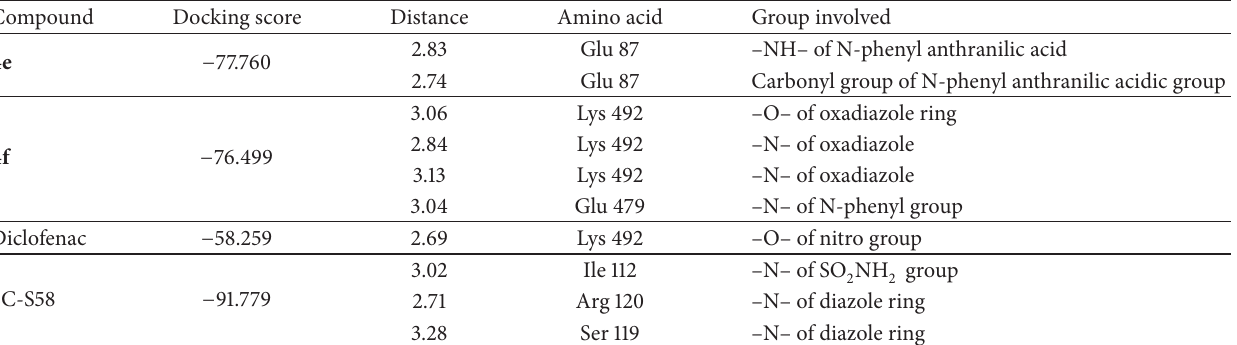
Figure5:Bindingmodesofdiclofenac,SC-S58(diclofenac,SC-S58asdockingviewanddiclofenac 󸀠 ,SC-S58 󸀠 asinteractionview)withCOX-2, where blue/green lines and red lines represent hydrogen bonding and favourable steric interactions, respectively. Table 3: Ligand-receptor interaction of target compound and standard